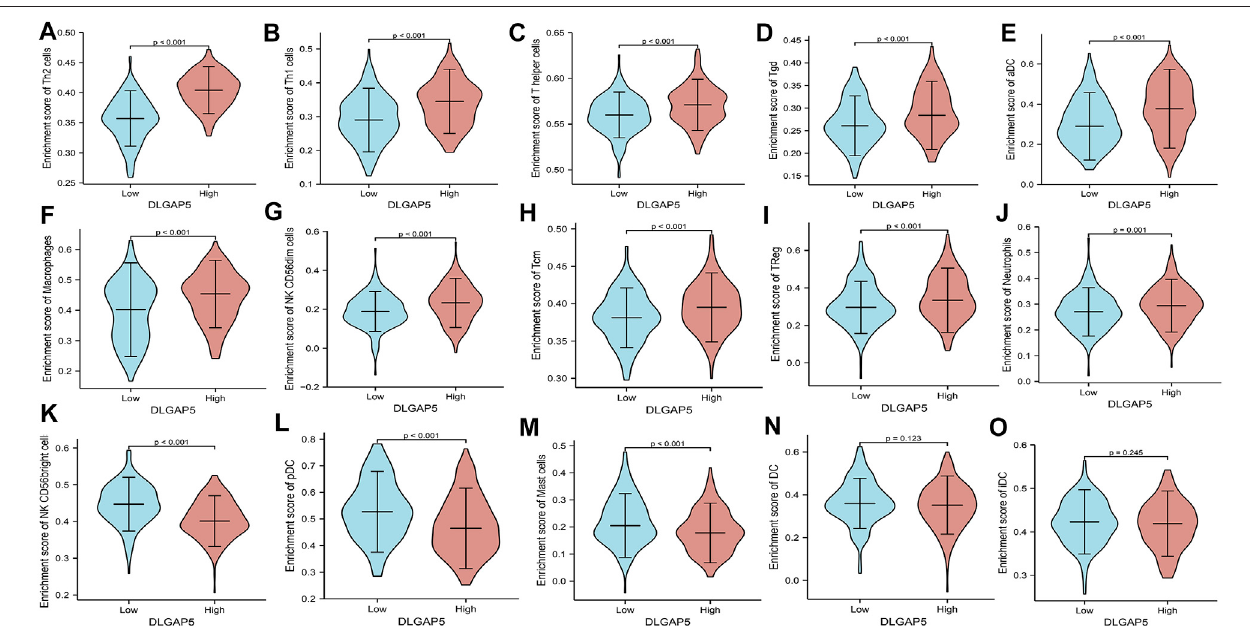
FIGURE5| Theenrichmentof15kindsofstatisticalimmunecellsinhighandlowDLGAP5.Th2cells(p < 0.001),Thlcells(p < 0.001),Thelpercells(p < 0.001),Tgd (p < 0.001), aDC (p < 0.001), Macrophages (p < 0.001), NK CD56dim cells (p < 0.001), Tam (p < 0.001), TReg (p < 0.001) and Neutrophils (p = 0.001) had more higher enrichmentlevelinhighlevelthanlowlevelofDLGAP5 (A – J) ,while NKCD56brightcells,pDC andMastcellshadmorehigher enrichmentlevelinlowlevelthanhighlevel of DLGAP5 (K – M) . DC (p,1).123 and iDC (p = 0.245) have no statistical signi fi cance between two groups (N,O) .